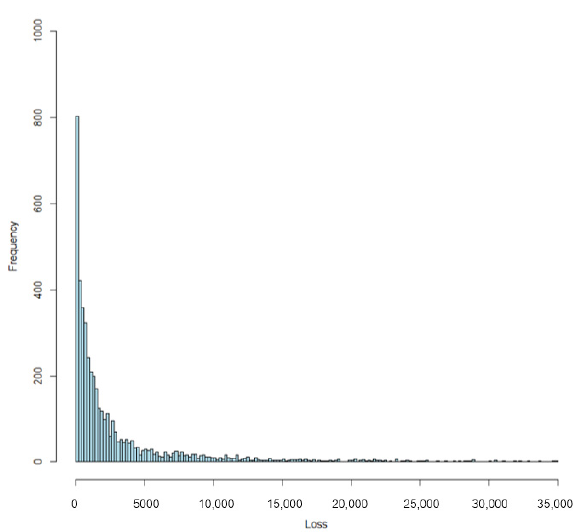
Figure 2. Histogram of the data set.